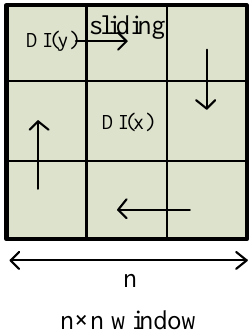
Figure 4. Process of the NLM